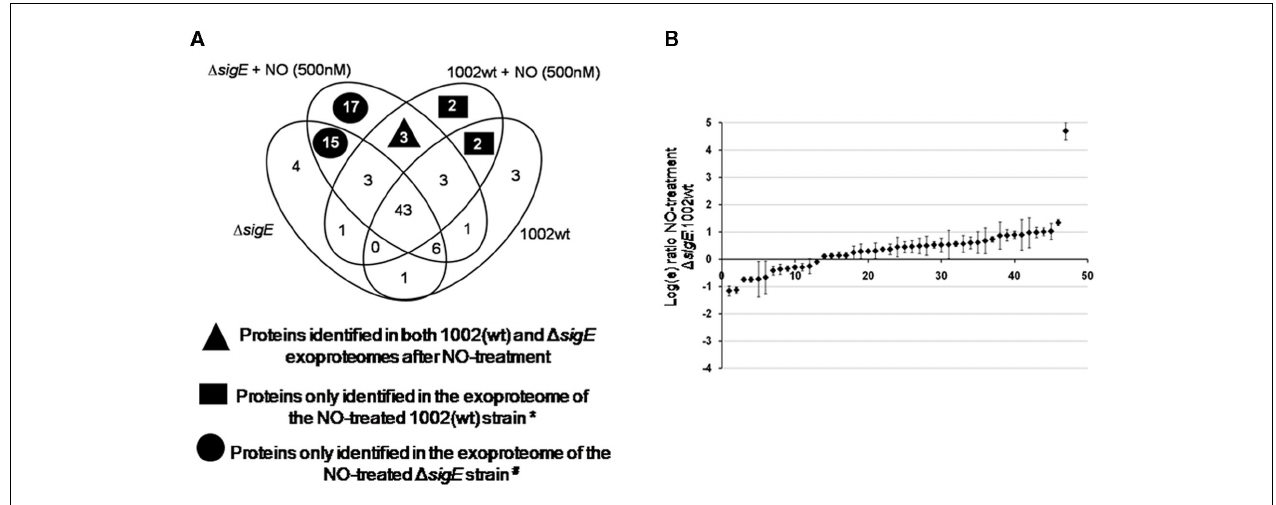
FIGURE 4 | Extracellular proteins identified in the 1002 (wt) and Δ sigE strains following NO-stress. (A) Venn diagram showing the distribution of the 104 different C. pseudotuberculosis extracellular proteins identified by LC–MS E analysis throughout the four groups studied: (i) 1002 (wt) untreated; (ii) 1002 (wt) + 100 μ M DETA/NO; (iii) Δ sigE untreated; (iv) Δ sigE + 100 μ M DETA/NO. *Compared to the NO-treated Δ sigE strain. # Compared to the